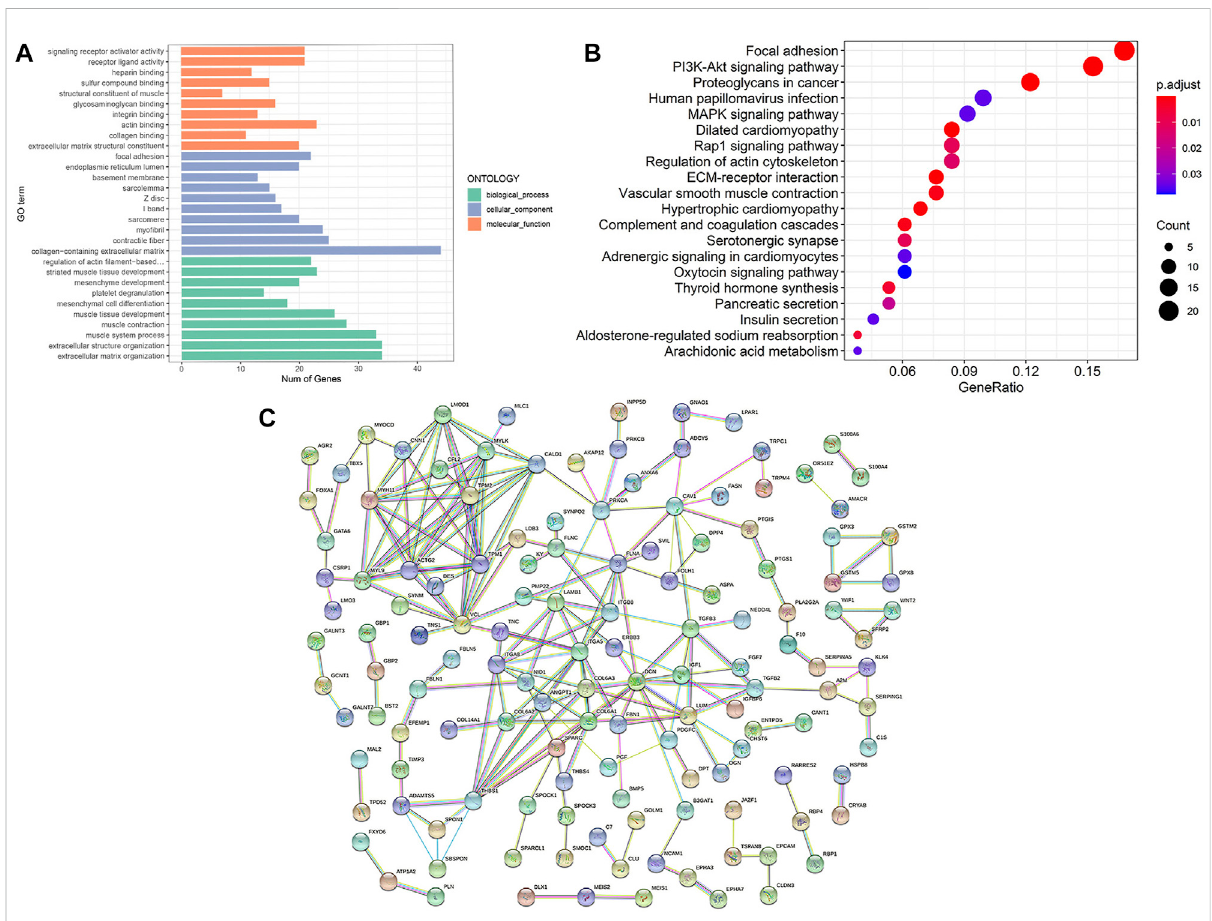
FIGURE 3 Results of enrichment analysis and PPI network. (A) The top 30 enriched signi fi cant GO categories of BP, CC, and MF. (B) The top 20 enriched KEGG pathways. The magnitude of gene counts is represented by the circle size, and the adjusted p value is represented by the legend ’ s color saturation. (C) PPI network of differentially expressed gene. BP, biological process; CC, cellular component; MF, molecular function; PPI, protein- protein interaction.